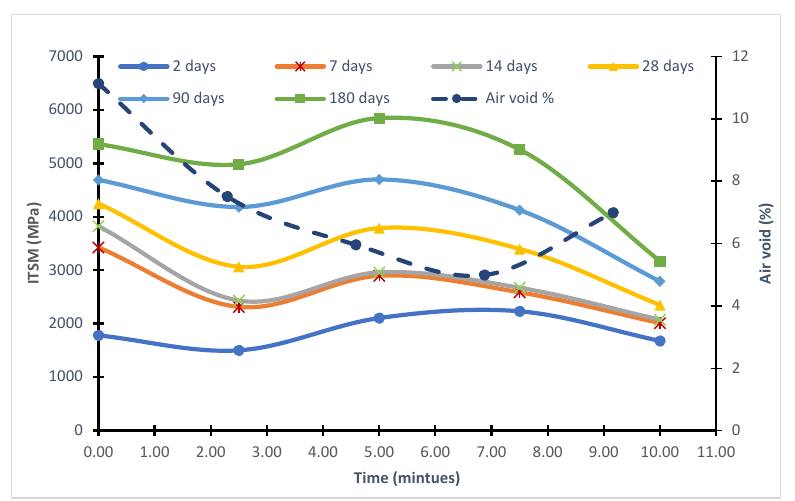
Figure 6. Effect of MW time on ITSM of CBEMs containing 5.5% PSA in terms of various curing times.